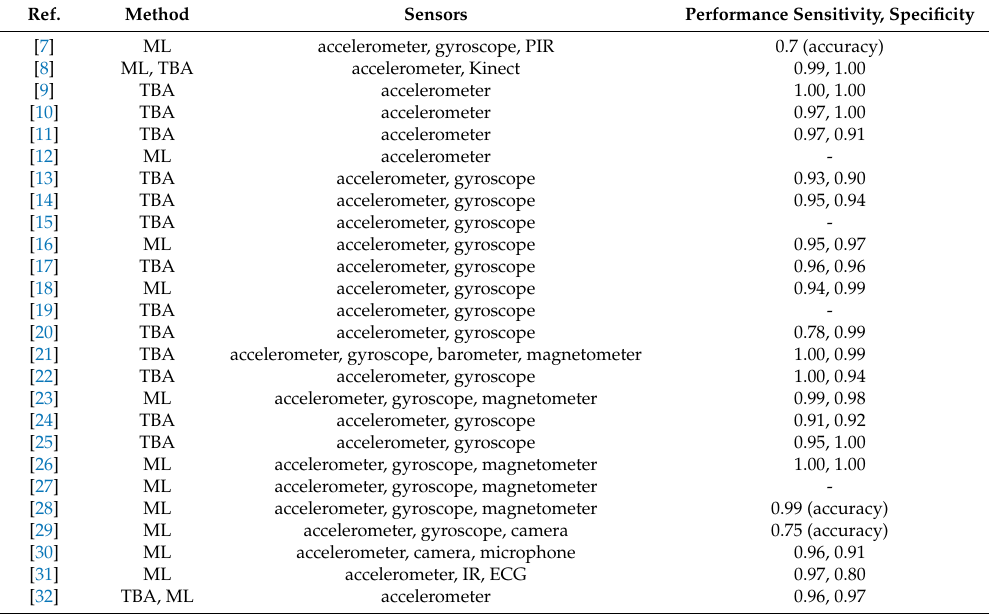
Table 1. Literature review of data fusion in fall